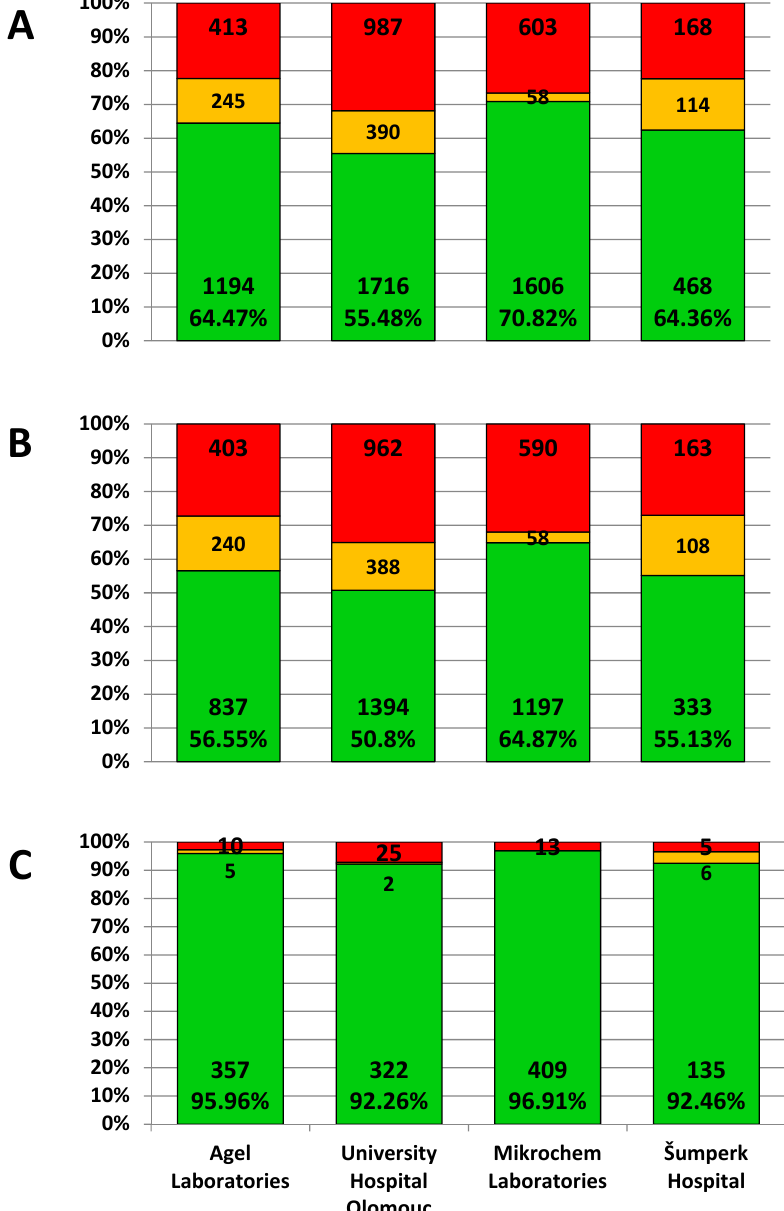
Figure 3. The proportion of positive (green), borderline (orange), and negative (red) results in individual laboratories. ( A ) Total values, ( B ) persons aged 52 years and younger, ( C ) persons aged 53 years and older. Using chi-square statistics performed on the entire study cohort and sub-cohorts of subjects ≤ 52 or ≥ 53 years of age (at the time of sampling), we observed significant differences in frequencies of negative, positive, and borderline values among all four